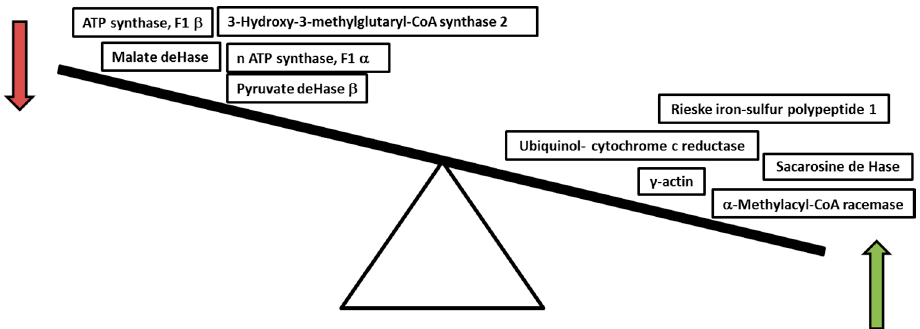
Figure 1. Mitochondrial proteins altered by high-fat diet.